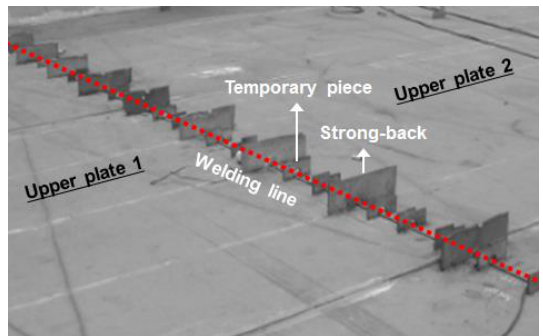
Figure 1. Temporary pieces set up for welding at block assembly stage.